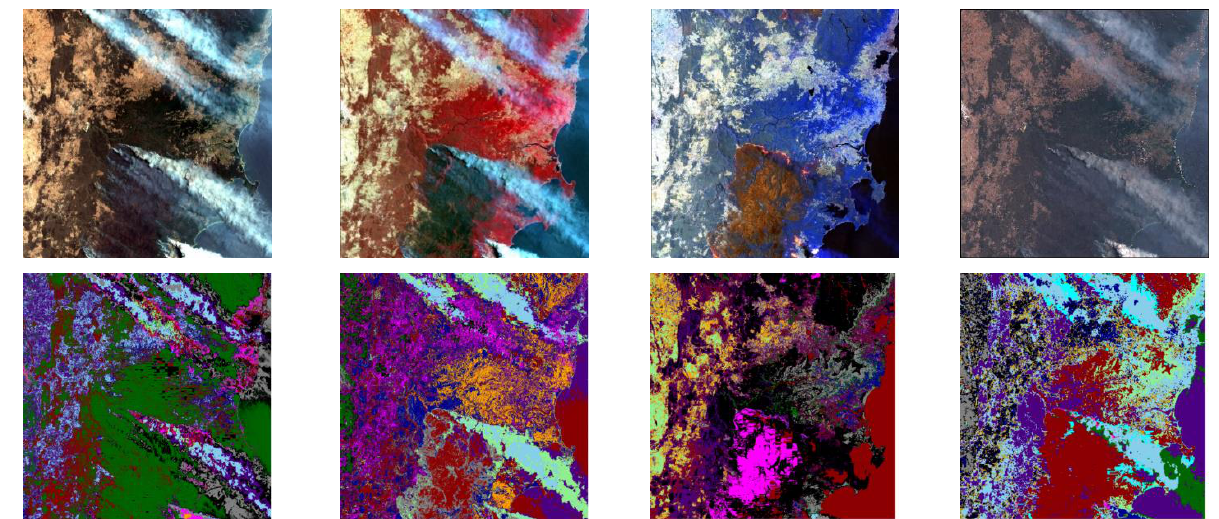
Figure 6 . The area of Sydney, Australia affected by forest fires on December 31 st , 2019. The visibility of the different classes depends on the selection of the Sentinel-2 colour bands. (From left to right, upper part): A quick-look image of visible false-colour bands (B4, B3, and B2), false-colour visible/infrared bands (B8, B4, and B3), false-colour infrared bands (B12, B11, and B8A), and all 13 bands. (From left to right, lower part): The information that can be gained from the topics extracted by LDA for the four band combinations. The topic colours are similar to Figure 2.